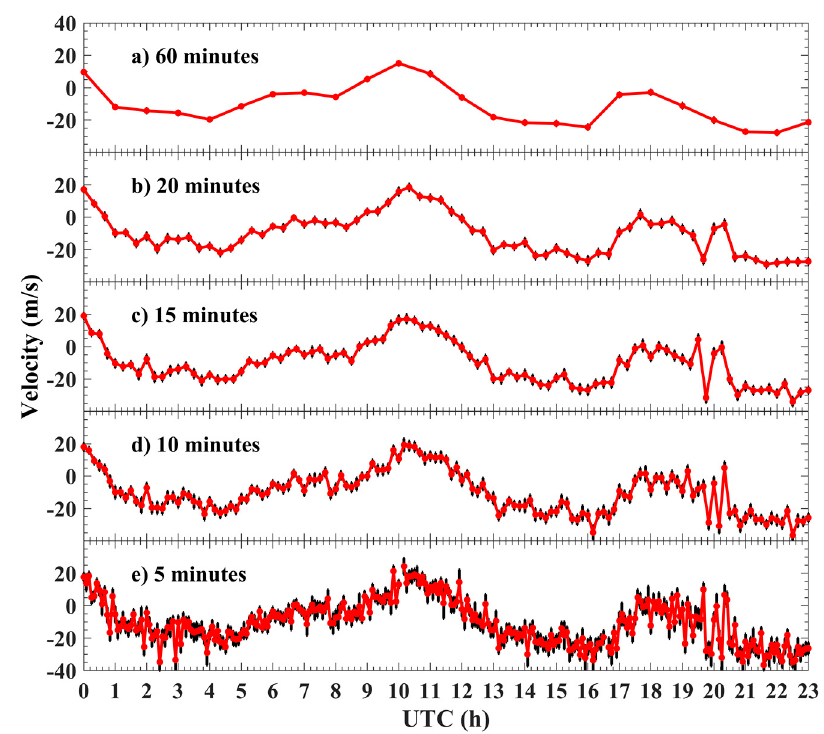
Figure 2. A typical example of zonal winds (red dot lines) retrieved by the least square fit under different temporal resolutions on 23 September 2013. The vertical black line in Figure 2a − e denotes error, which is estimated from Equation (4).